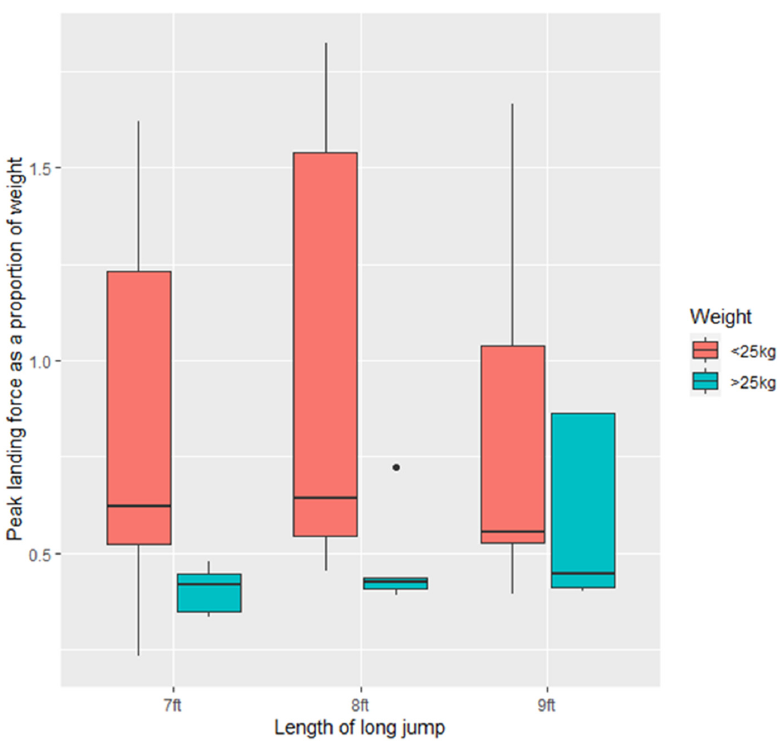
Figure 5. Peak vertical landing force (PVF) as a proportion of body weight (N/kg) across all the study dogs ( n = 21) at the three long jump lengths (7 ft, 8 ft, 9 ft). Peak vertical landing force as a proportion of dog body weight was variable across dogs. Lighter dogs (<25 kg) had a greater PVF in proportion to their body weight than dogs >25 kg ( − 0.44 ± 0.18, t = − 2.422, p < 0.05). There was greater variation in PVF as a proportion of body weight in dogs <25 kg (F = 2.8542, p < 0.05) (Figure 5). Individual Variation Individual variation was observed in terms of equality of peak vertical force on each paw on landing. The difference between mean PVF on the two front feet in the study dogs is displayed in Table 2. Descriptively, it appears that some dogs have greater variation in the landing pressure on each foot (e.g., dog 2 and dog 21) and others show more con- sistency (e.g., dog 5), indicating that some dogs may exert more force on one particular limb than those who land more symmetrically. There was no significant difference be- tween the difference in peak vertical landing force as a function of the length of long jump ( p > 0.05) or bodyweight of the dog ( p > 0.05). There was no significant variation between the difference in PVF between front feet for dogs <25 kg or >25 kg ( p > 0.05) (Figure 6). Table 2. Mean difference (±SD) between peak vertical landing force on dogs two front feet. PVF was only calculated when both feet successfully landed on the mat (and recorded maximum landing force on Tekscan mat). DogNumber Successful Replicates